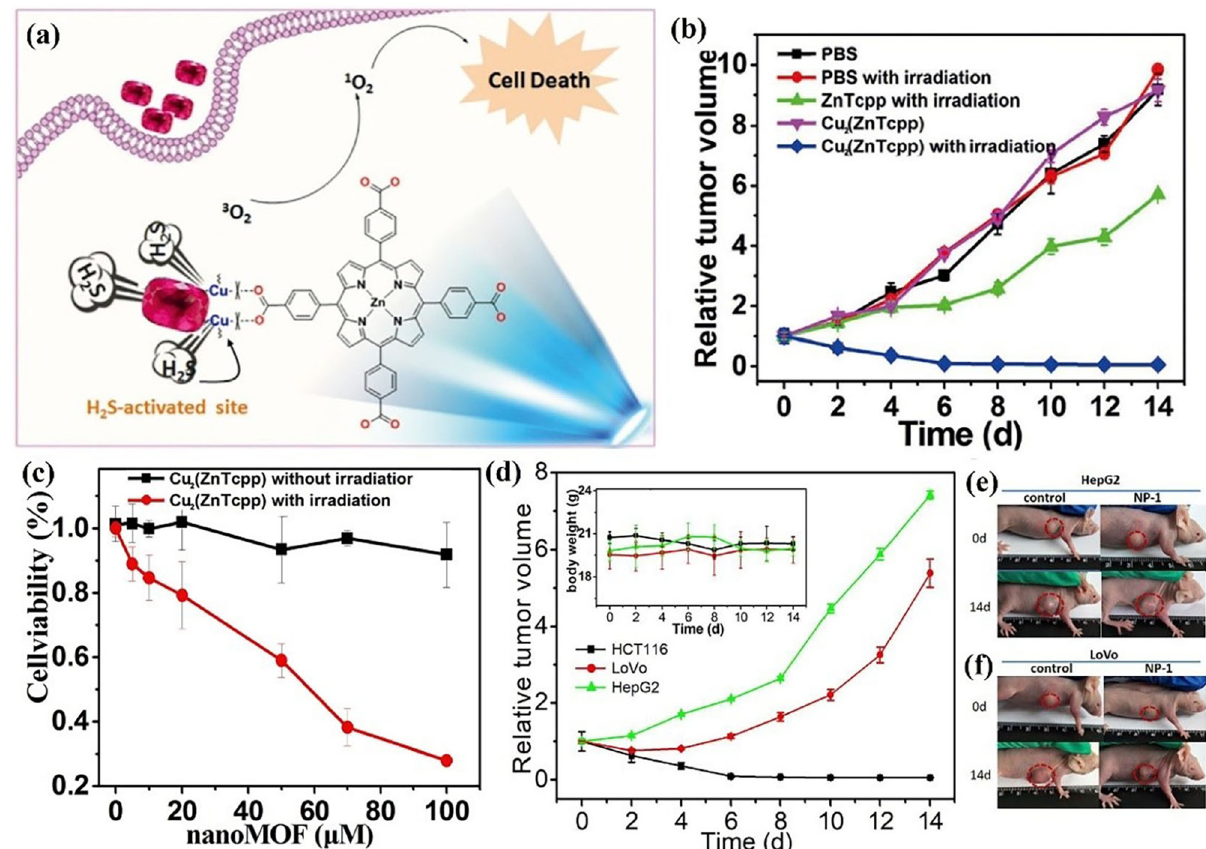
Figure 8: ( a ) Schematic illustration of MOF NP - 1 structure and mechanism of action. ( b ) Tumor growth inhibition in di ff erent treatment groups. ( c ) MTT assay of the HCT116 cells in the presence of di ff erent concentrations of NP - 1 activated by intrinsic H 2 S. ( d ) Tumor growth inhibition curves for three cell models after the treatment of 1.0 mg mL − 1 NP - 1 dispersed in PBS bu ff er. ( e – f ) Photographs of HepG2 and LoVo tumor - bearing mice in PBS group and NP - 1 group, respectively. Reprinted with permission from Ref. [ 50 ] ; Copyright © 2017 Wiley -